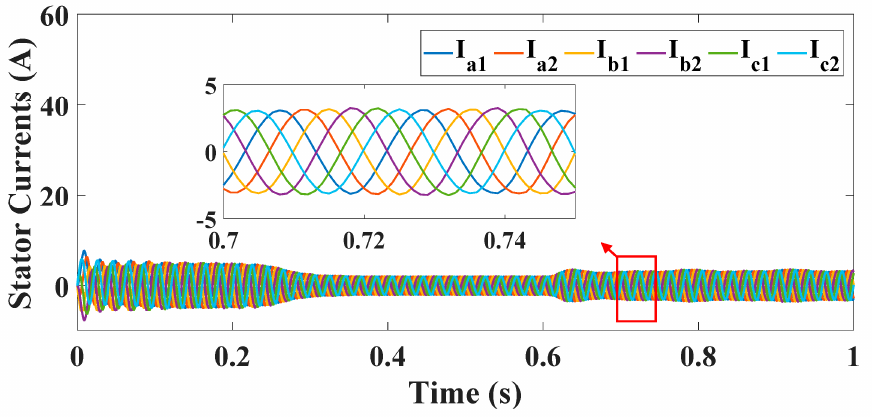
Figure 15. BRB-stator phase currents.